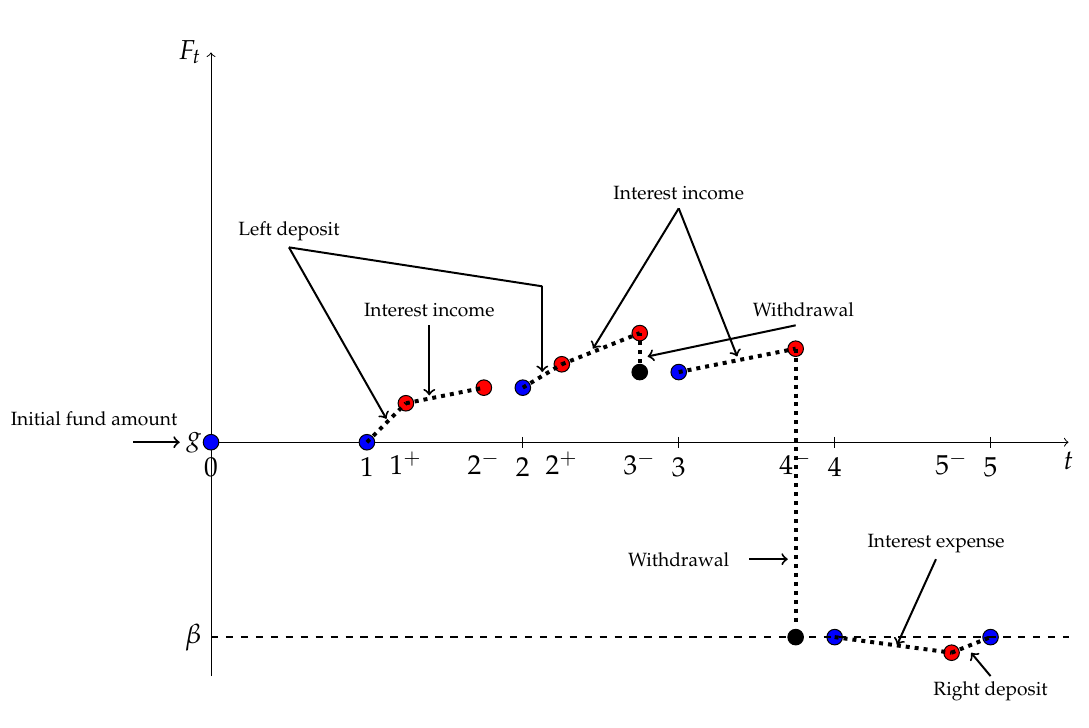
Figure 2. Sample evolution of the external fund process { F t , t ∈ N }